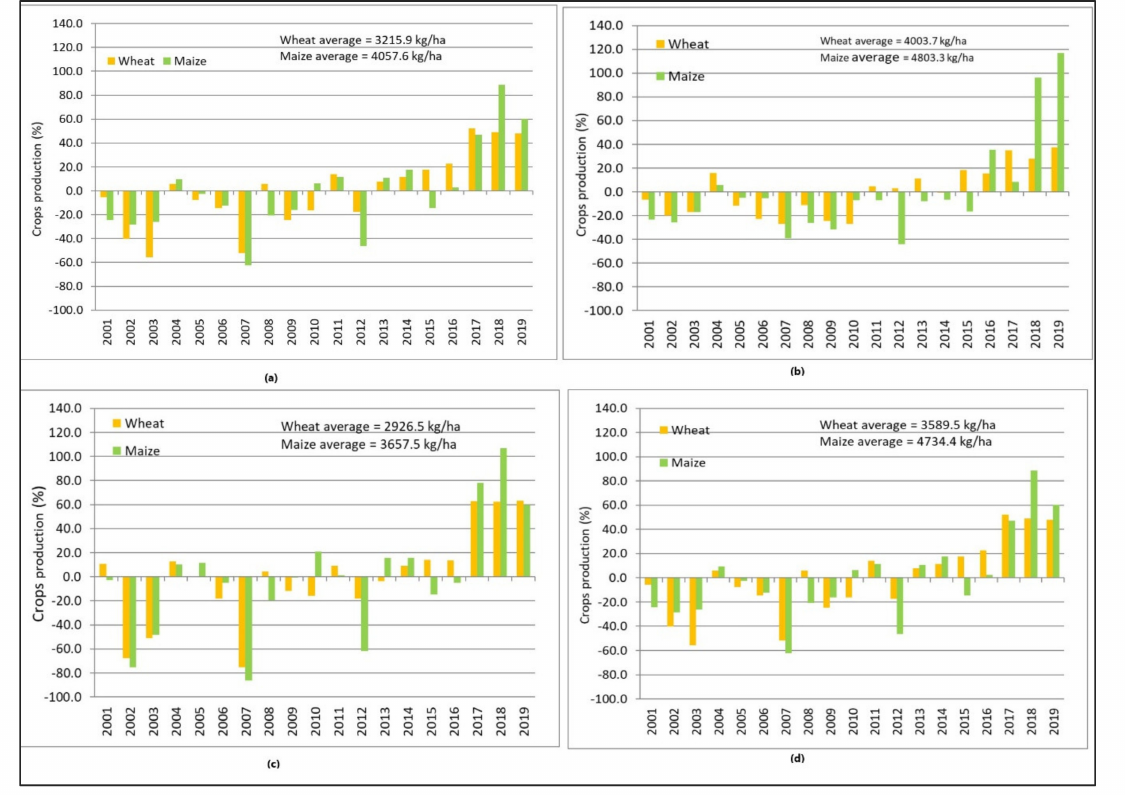
Figure 12. Production of wheat and maize crops in ( a ) Romania, ( b ) Banat Plain, ( c ) Oltenia Plain ( d ) Baragan Plain, compared to the average of the 2001–2019 period (data source: